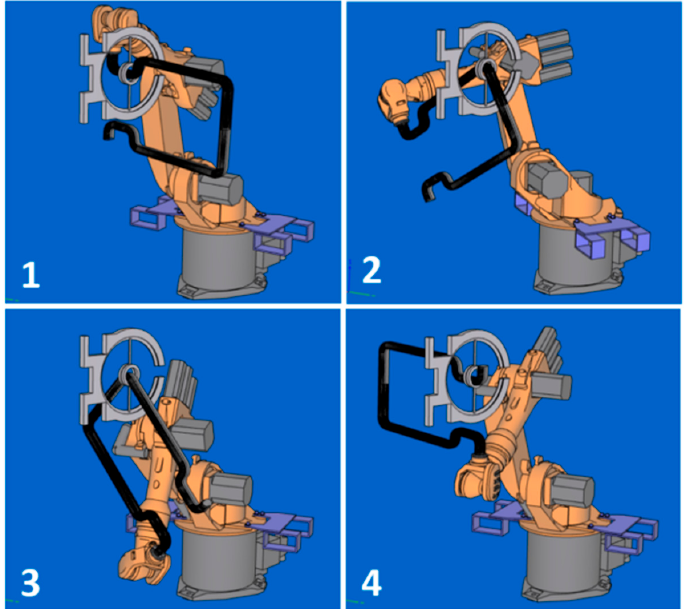
Figure 18. Test 1—the graphical simulation of the robot position and the frame in BCS in the winding at four selected points ( 1 – 4 ) of optimal trajectory.